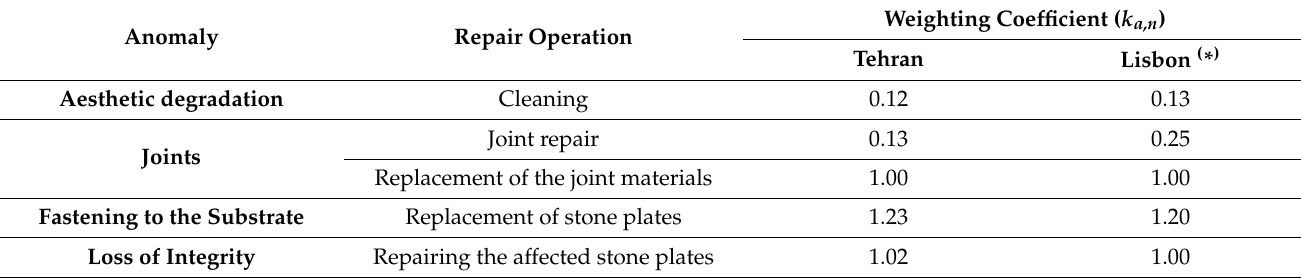
Table 3. Weighting coefficients corresponding to the relative importance of each group of defects. Anomaly Aesthetic degradation Joints Fastening to the